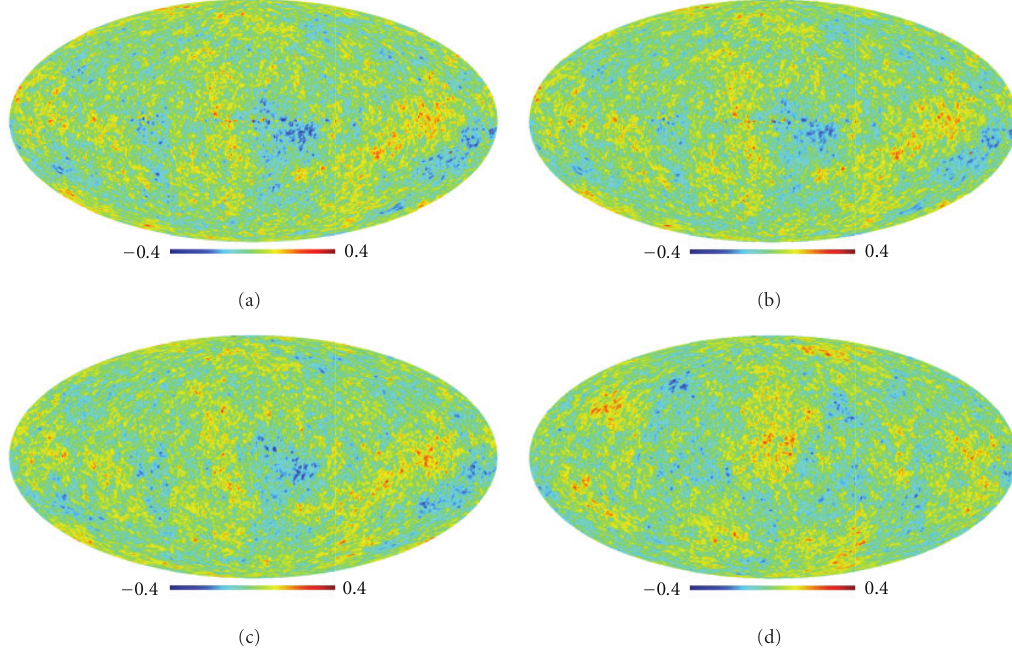
Figure 4: The ILC map in its original form (a) and after remapping of the temperatures and phases (b). First-order (c) and respective second-order surrogate (d) for l cut = 20. Note the resemblance of the remapped with the ILC map for all, but also of the first-order surrogate with the ILC map at large